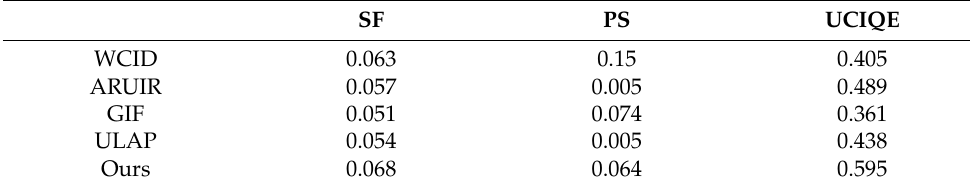
Table 2. Quantitative analysis of Figure 6.